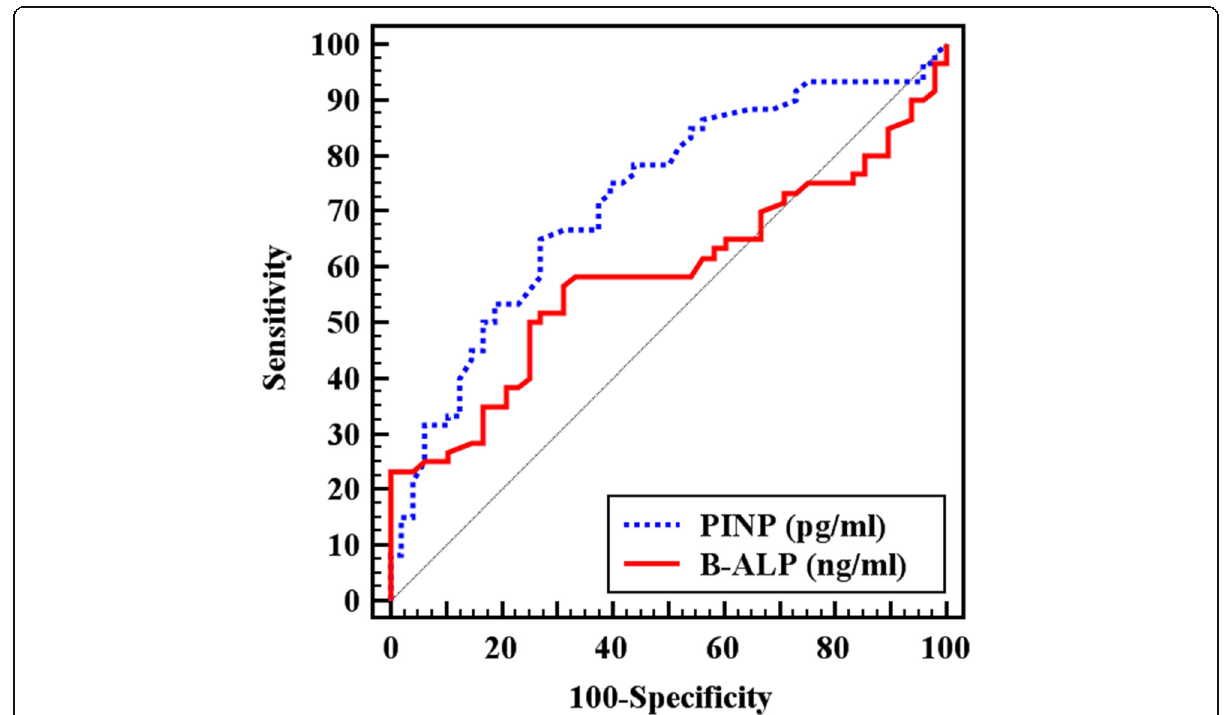
Fig. 3 ROC curve for PINP and B-ALP to discriminate osteoporosis patients from osteopenia